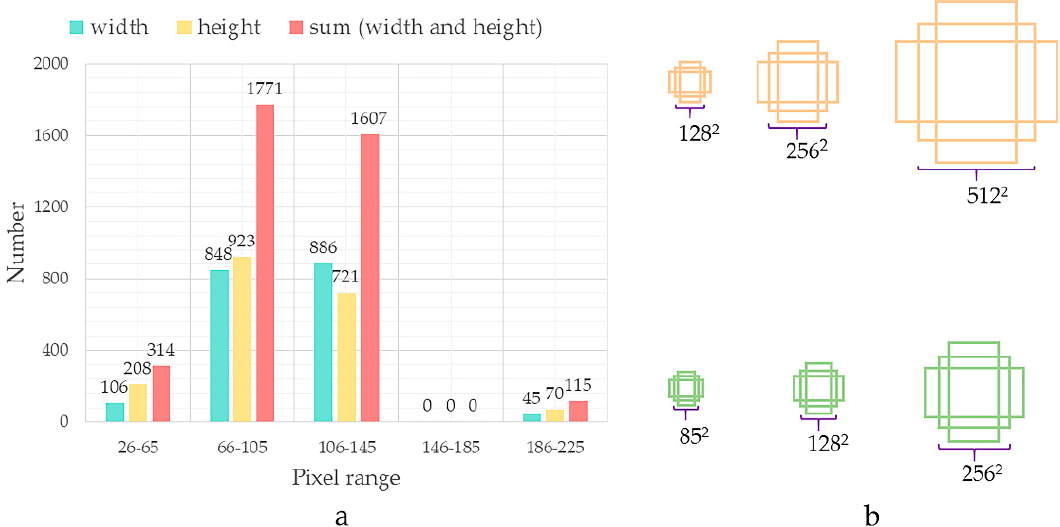
Figure 4. ( a ) The distribution of pixels in the maize tassel images. ( b ) The default and modified anchor sizes are colored with orange and green.